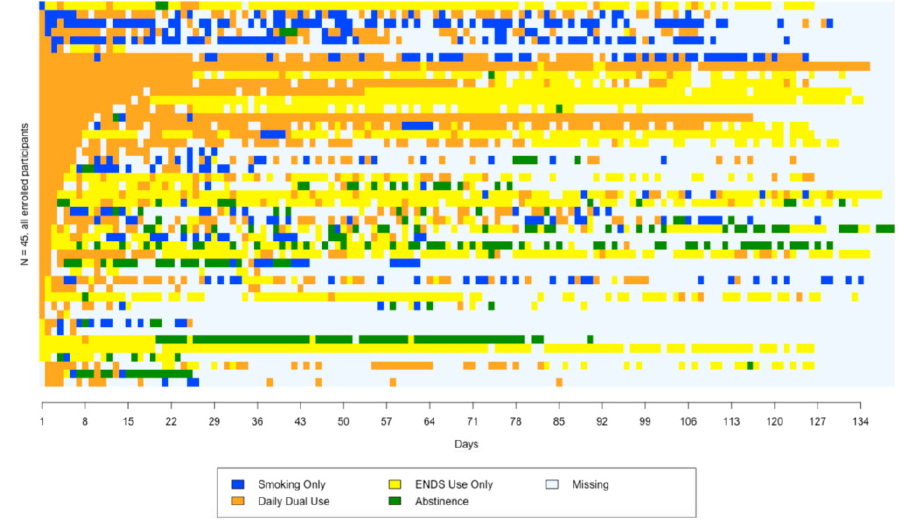
Figure 2. Sequence plot of smoking and ENDS usage by